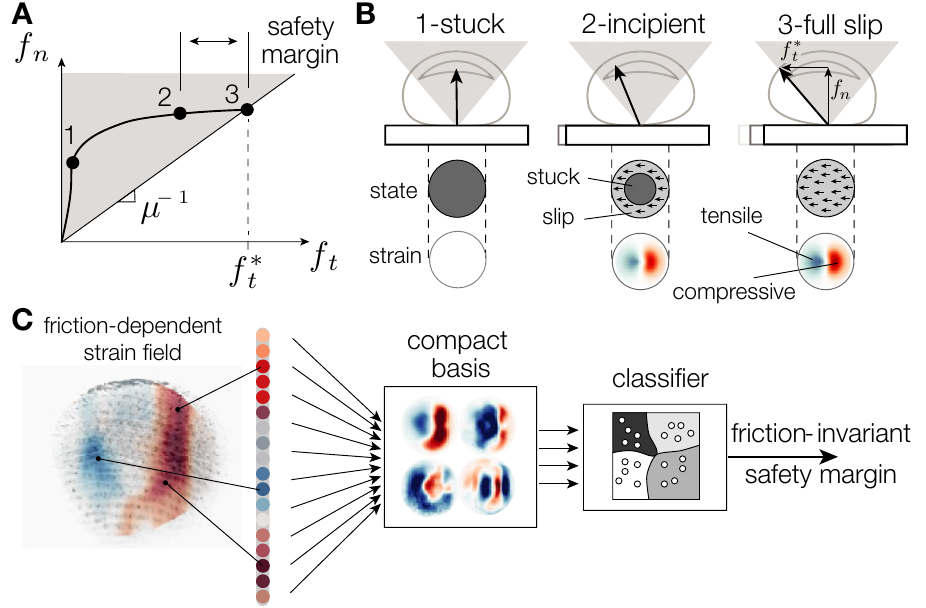
Figure 1. ( A ) Normal and tangential components of the force during grasping. To avoid slippage, the nervous system regulates the grasping force f n to keep the frictional strength f t = µ f n at a safety margin from the load force applied by the object. ( B ) Typical evolution of the interaction force, area of contact, and skin deformation during the transition from stick to slip. ( C ) Steps of perceptual computation from a strain field that is influenced by the frictional interaction to an estimate of the safety margin which is independent of